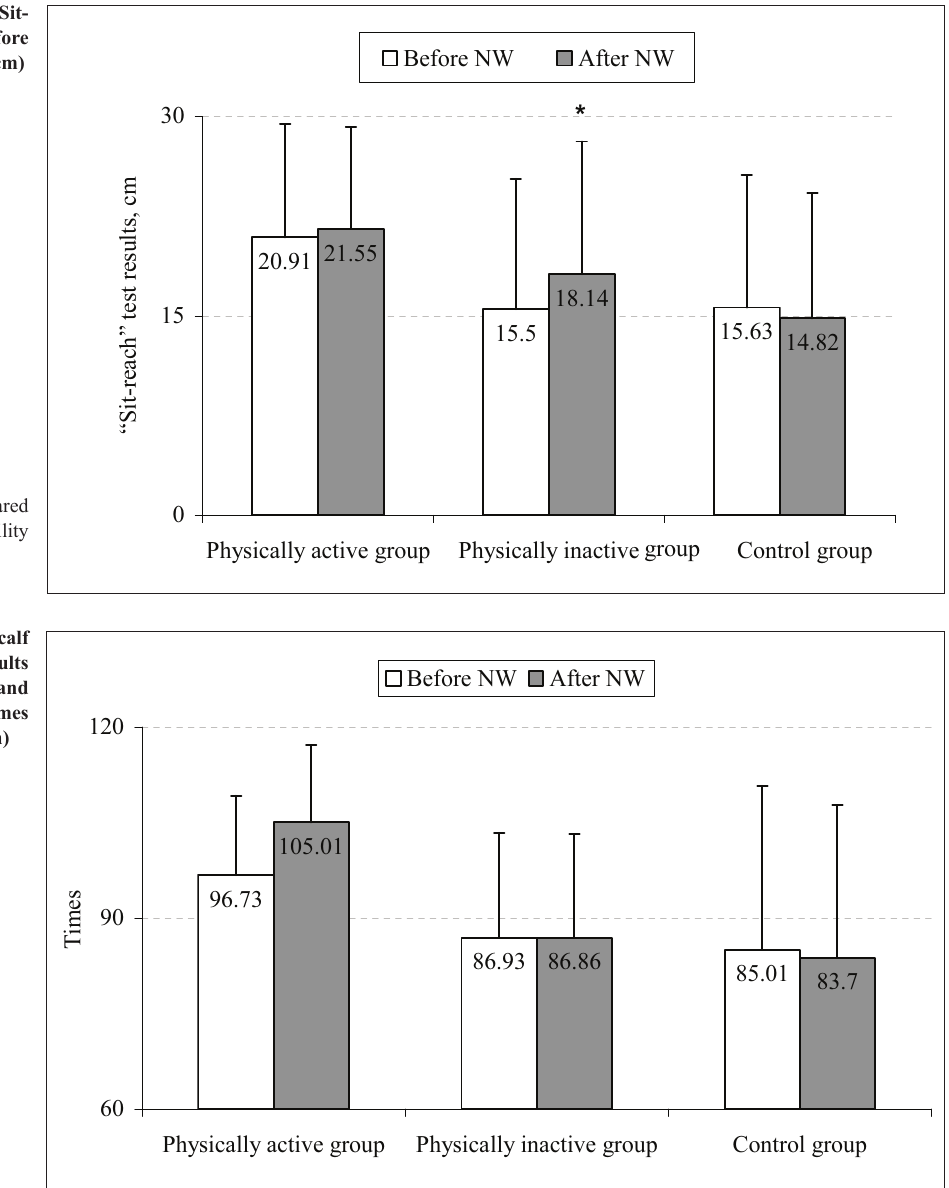
Figure 5. Subjects’ calf endurance test results distribution before and after the NW training (times of standing on tiptoe/min)